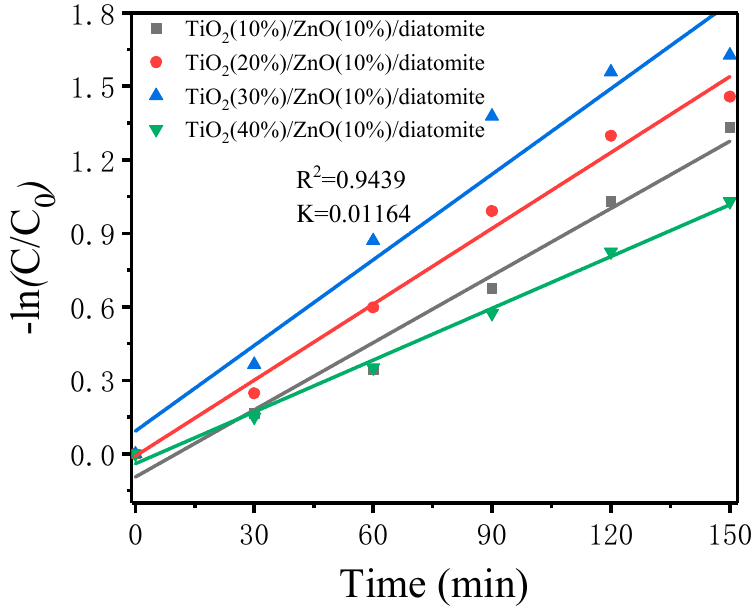
Figure 9. Curve fitting of the primary kinetics for photocatalytic degradation of MB.